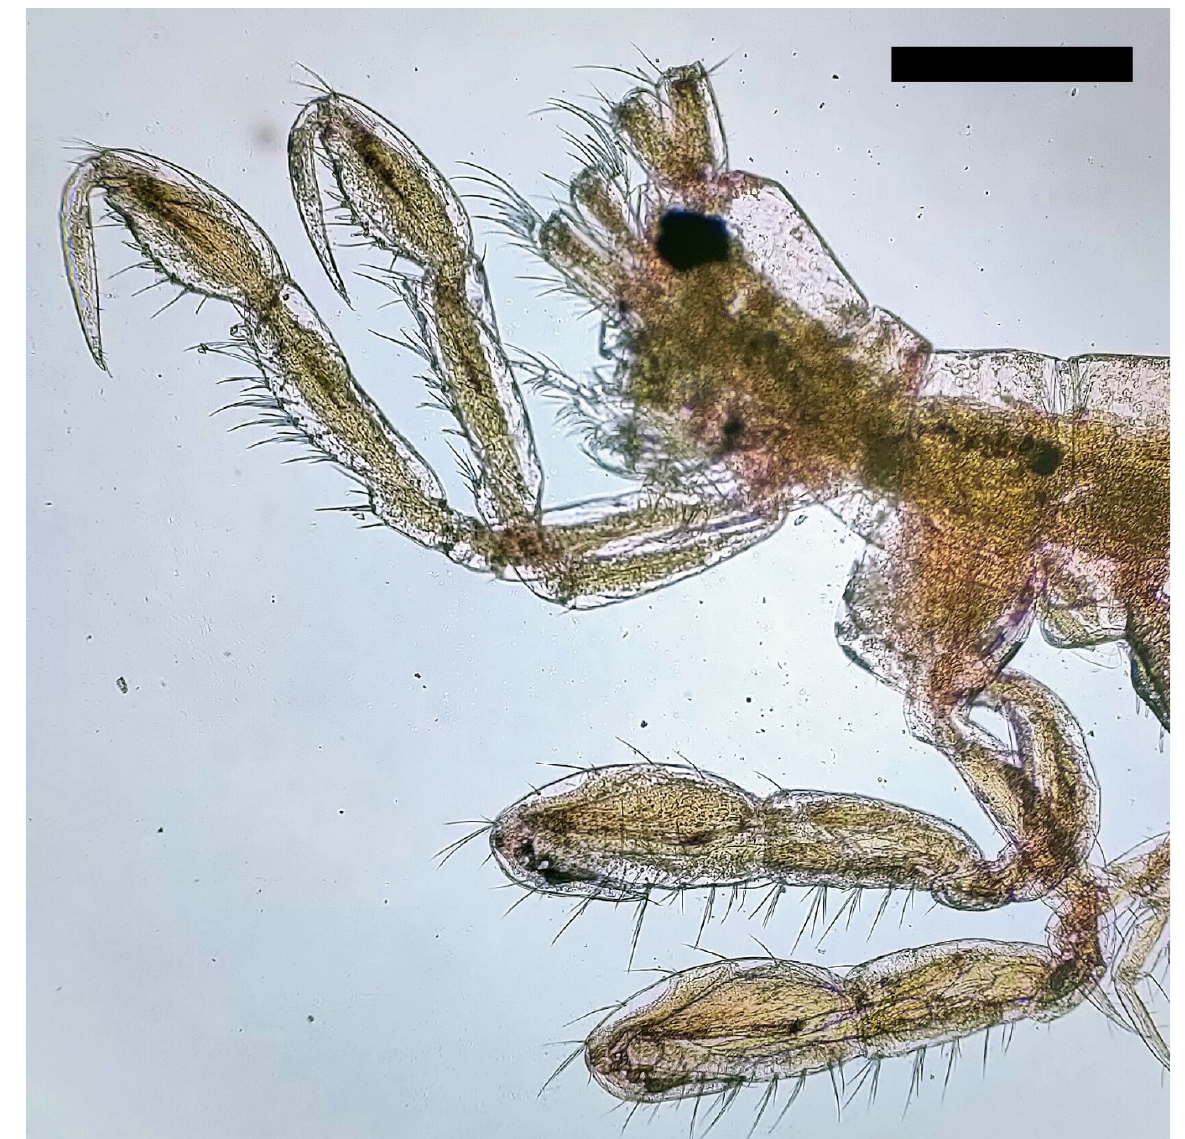
Figure 4. Megamphosus katagani : lateral view of anterior region (antennae broken off). Scale bar: 0.5 mm. Photo credit: Emanuele Mancini.